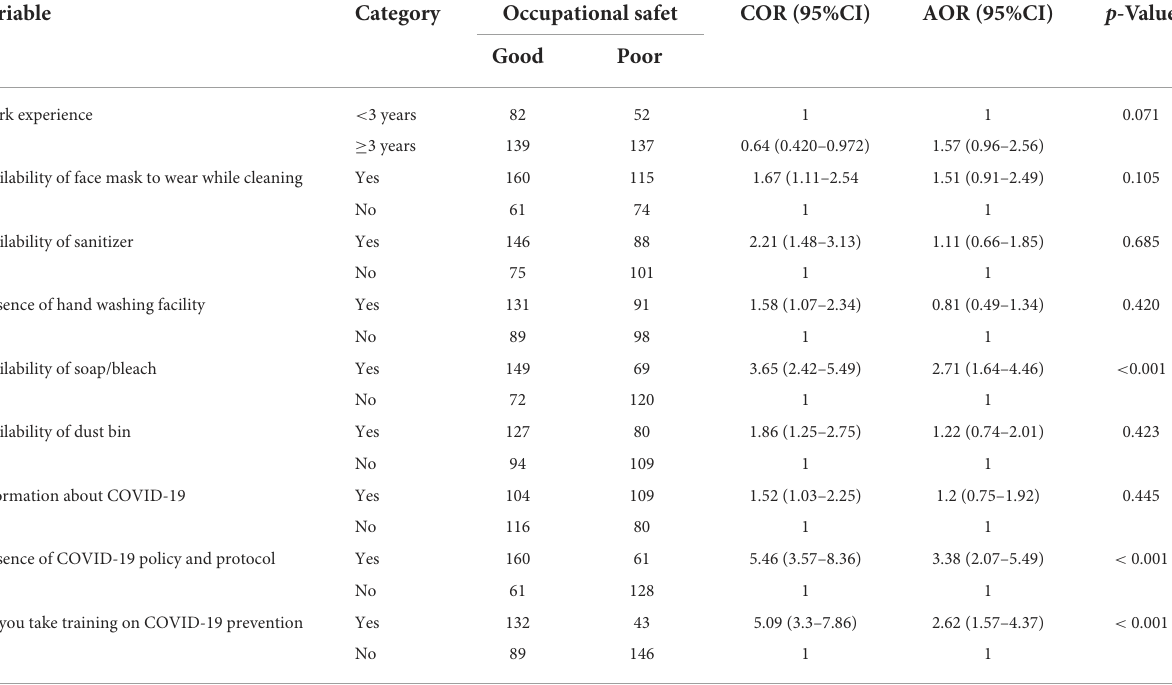
TABLE 5 Multivariable analysis of factors associated with occupational safety practice among the janitors of Bule Hora University from November to December 2021.